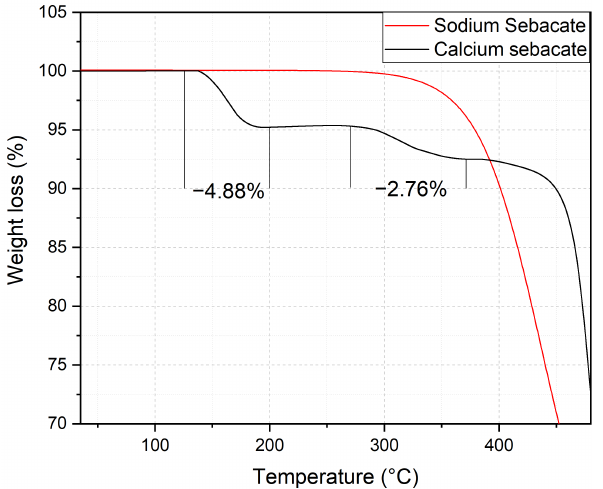
Figure 6. TGA analysis of calcium sebacate (black) and sodium sebacate